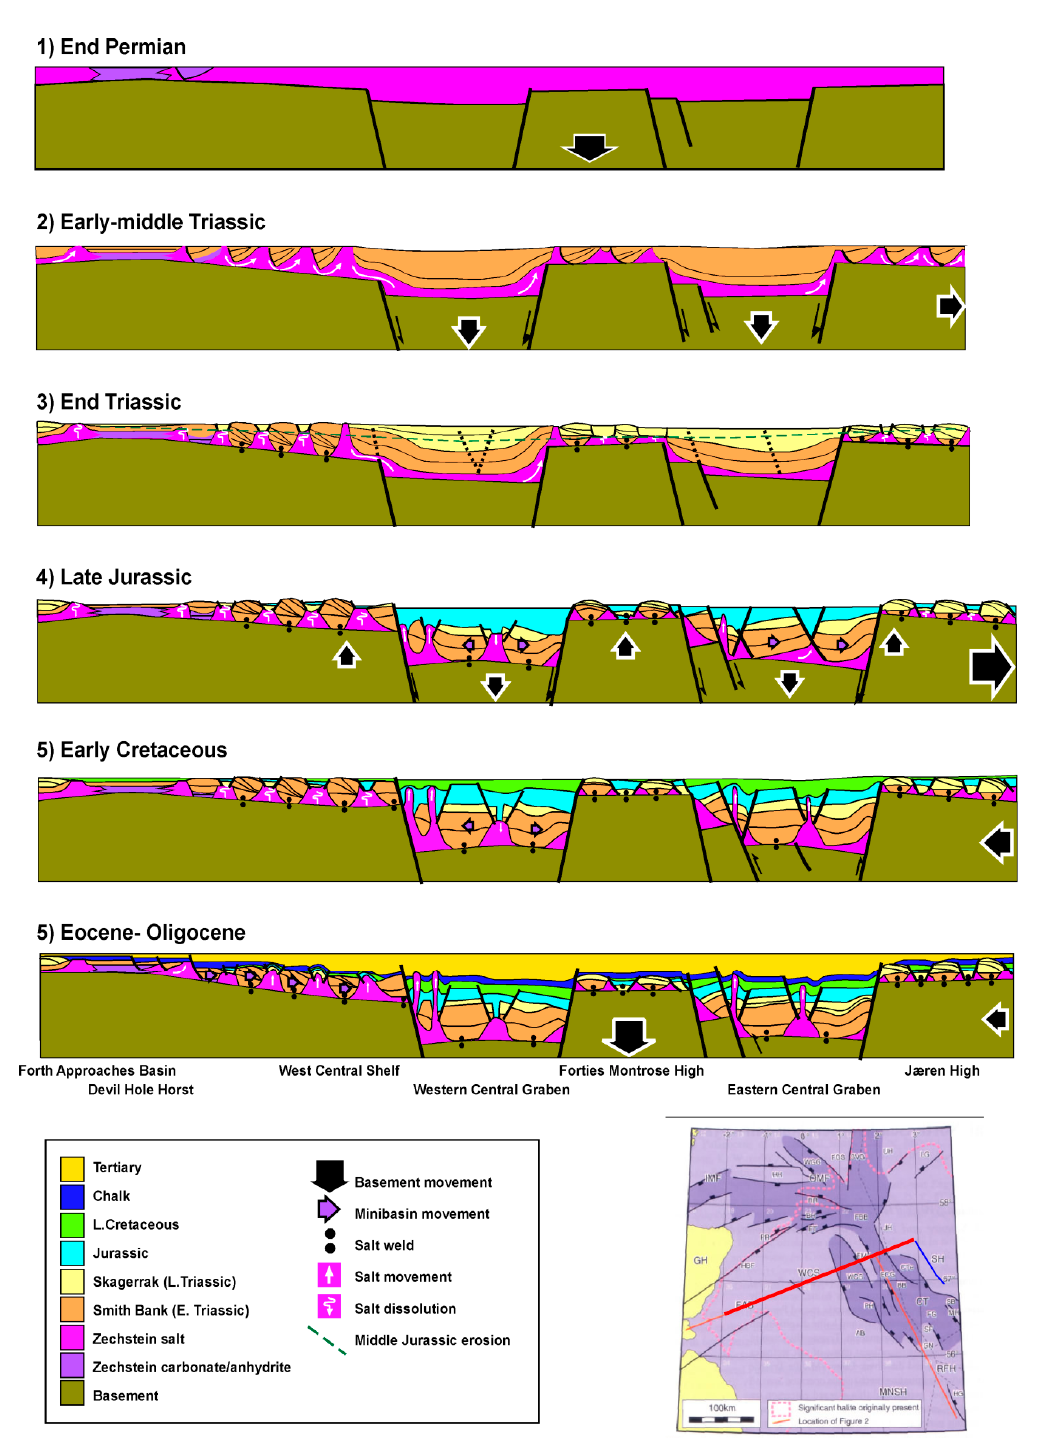
Figure 4. General section across the Central Graben showing the sequential evolution of salt structures. The study area is situated on the Jæren High to the right on this figure. The inset map shows the position of the regional transect in red. The Figure is modified from Reference [3]. The modeled structures of this study are based on typical structures from Eastern Central Graben (Model 1) and Jæren High (Model 2) whose position is shown as a blue line.